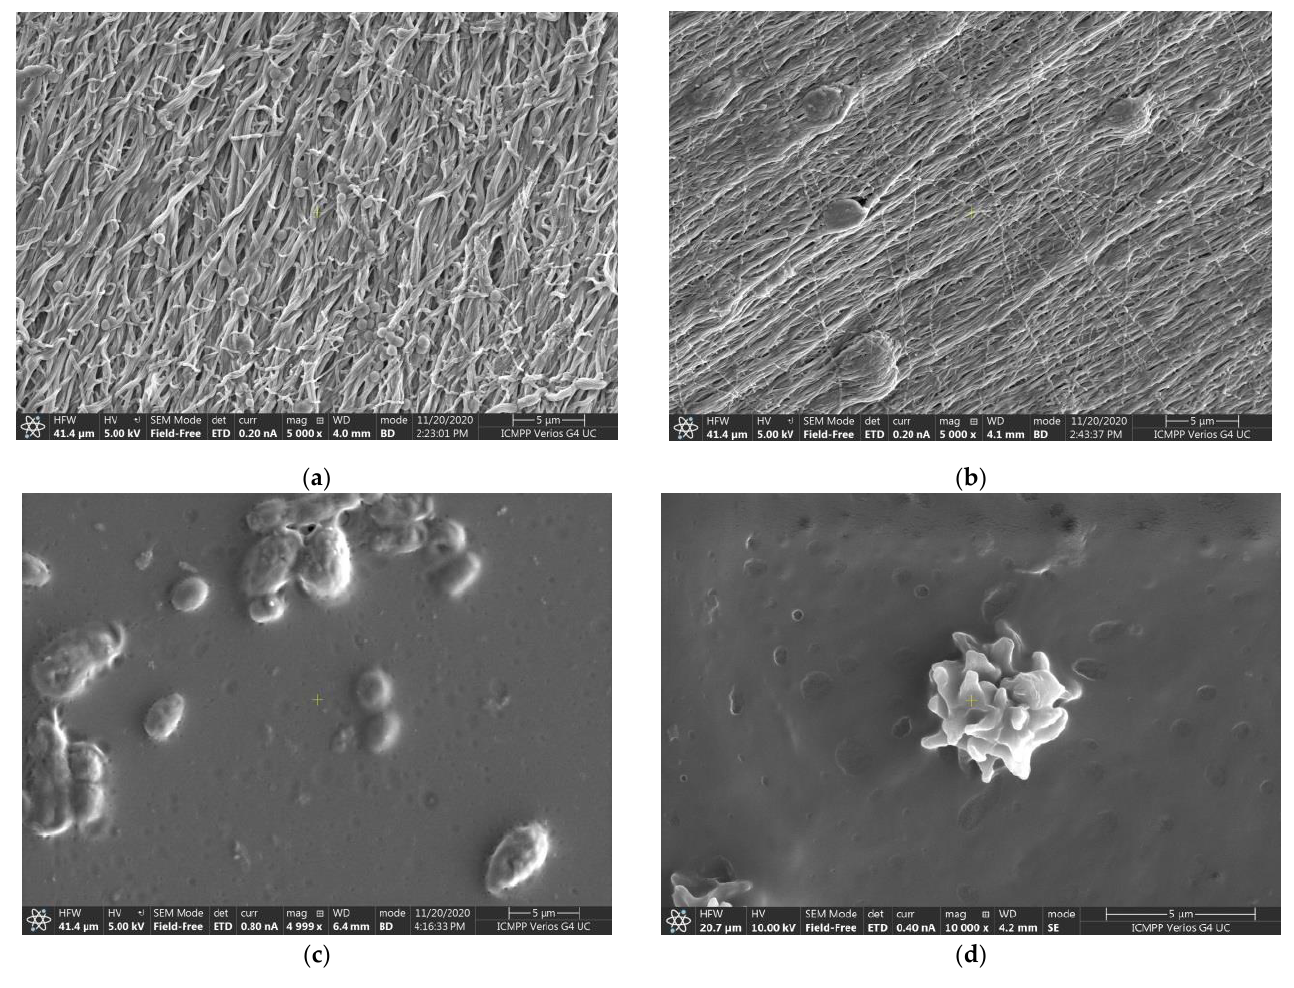
Figure 10. SEM images of the samples incubated with different pathogens, showing rare bacterial / fungal cells, fungal spores and overall no biofilm formation. ( a ): BC4 treated with S. aureus ; ( b ): BC1R treated with S. aureus ; ( c ): BC1 treated with C. albicans ; ( d ): BC6 treated with A. brasiliensis .